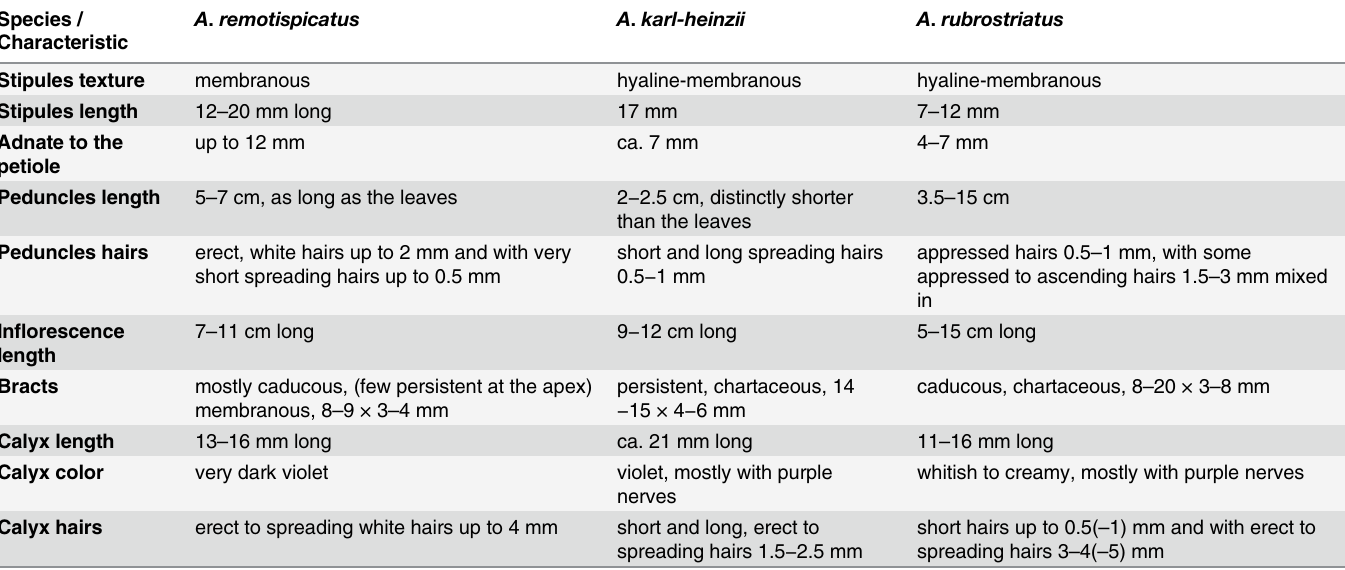
Table 4. Differences between Astragalus remotispicatus , A . karl-heinzii and A . rubrostriatus